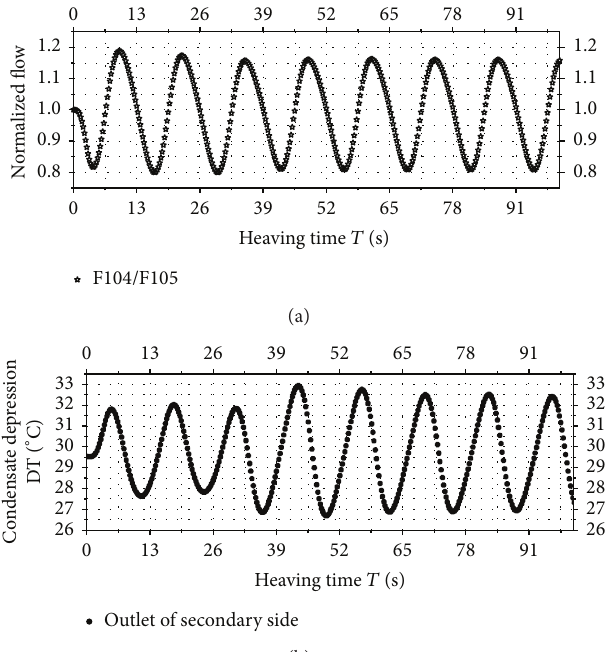
Figure 6: Flux of primary side of heat exchanger and condensate depression of outlet of secondary side: (a) normalized flow; (b) condensate depression.